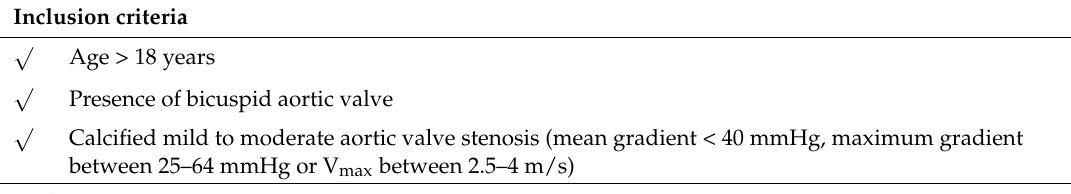
Table 2. Eligibility